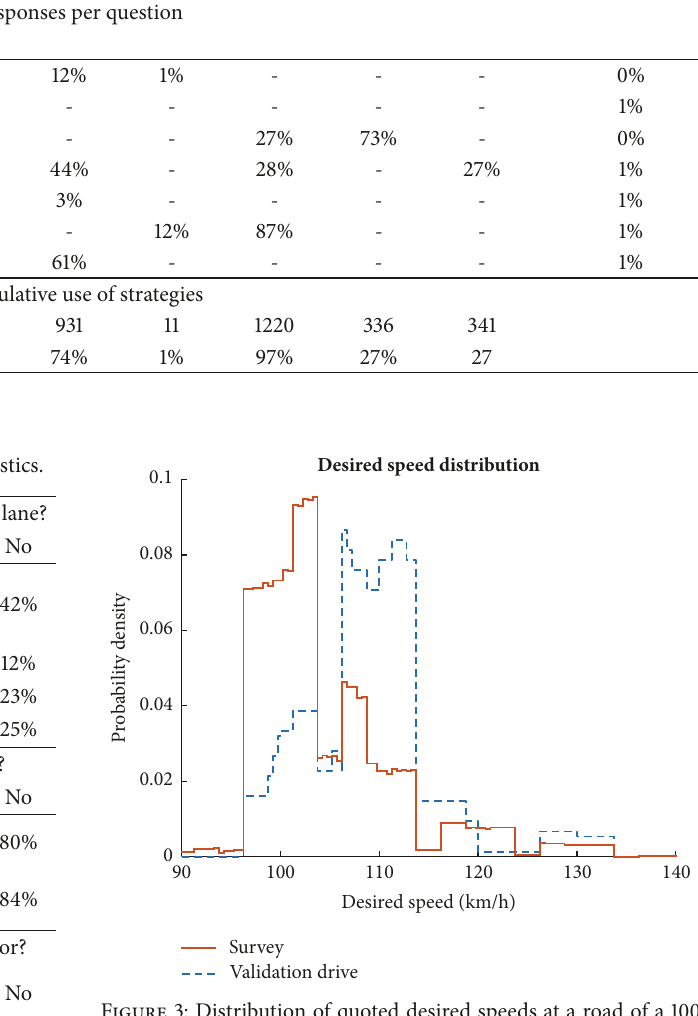
Figure 3: Distribution of quoted desired speeds at a road of a 100 km/h speed